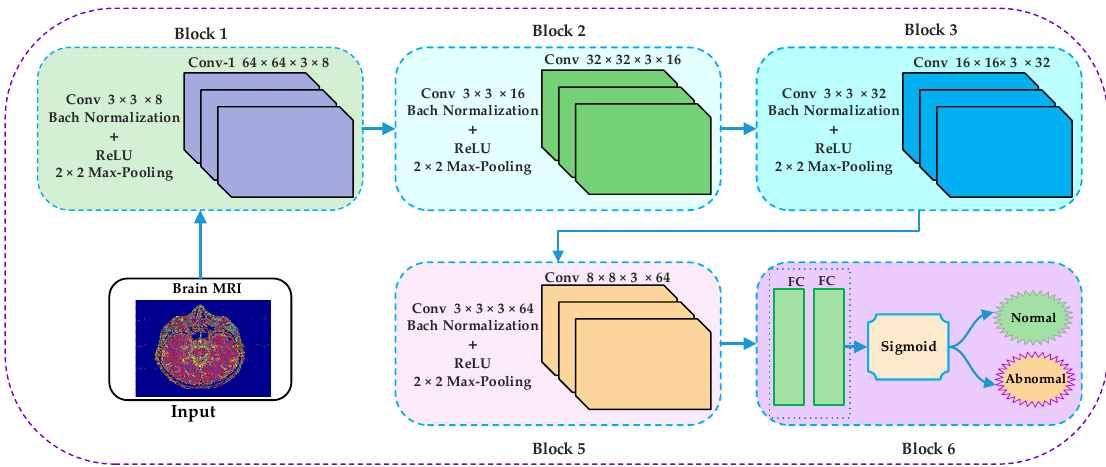
Figure 5. Block ‐ wise architecture of the proposed model. Figure 5. Block-wise architecture of the proposed